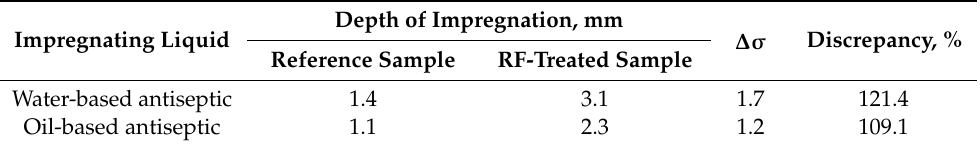
Table 1. Determination of impregnation depth.